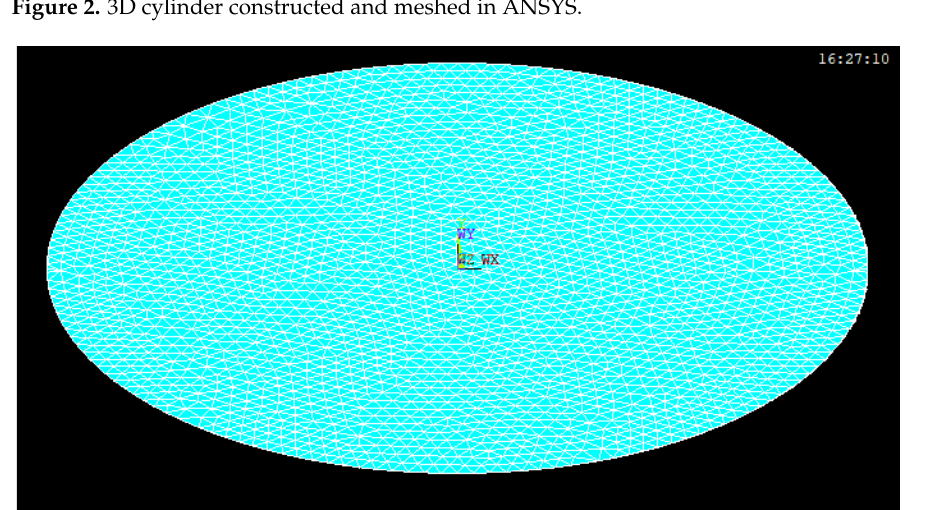
Figure 3. 3D elliptic disc constructed and meshed in ANSYS.